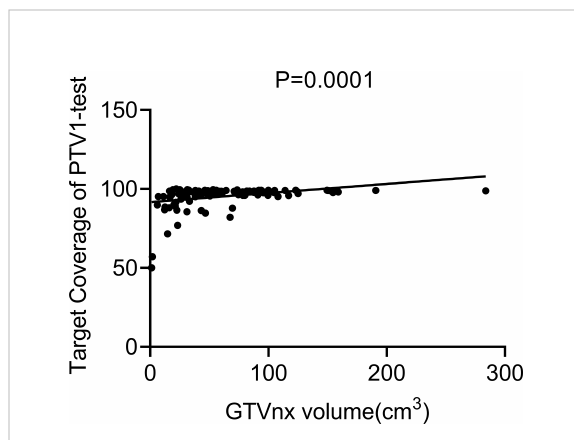
FIGURE 3 Correlation analysis chart between GTVnx volume and the target coverage of PTV1.